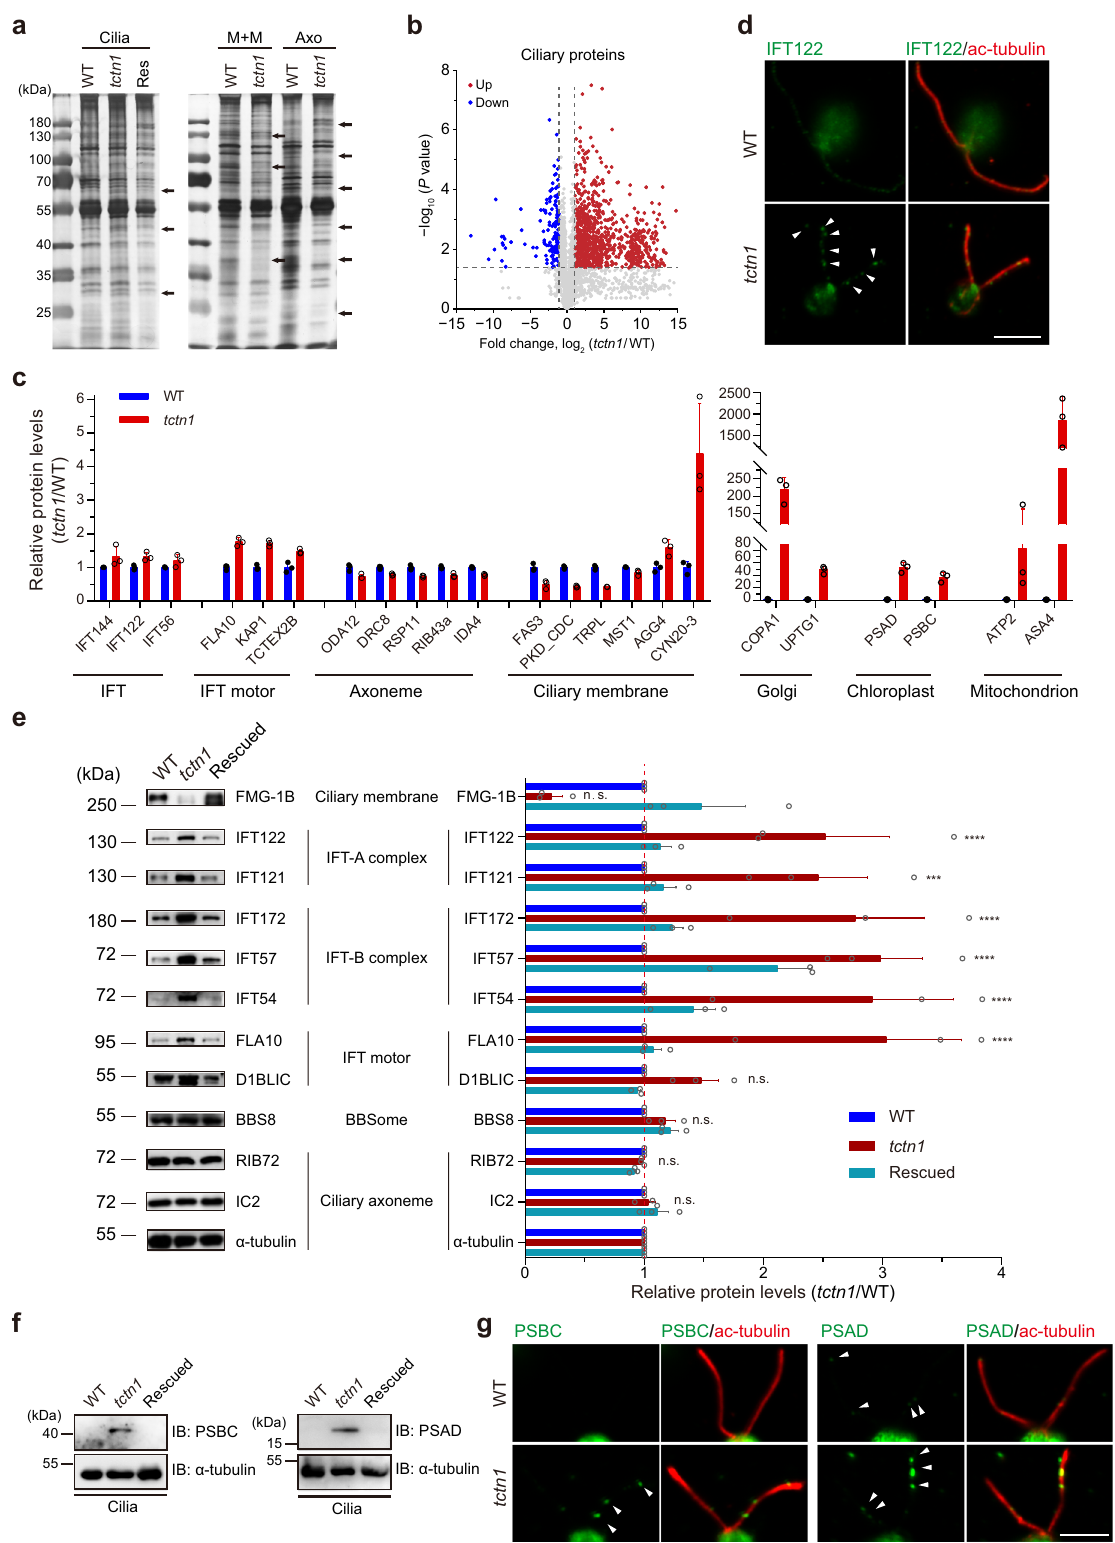
proteins, we performed proteomic analysis of WT and tctn1 cilia. of WT and tctn1 were isolated and subjected to silver gel staining Unexpectedly, a volcano plot showed that more proteins in cilia and proteomic analysis. Total ciliary protein (Cilia) and the were increased in tctn1 (Fig. 4b), which indicates that defects in membrane-matrix (M + M) and axonemal (Axo) fractions from the TZ not only impaired ciliary membrane protein concentration the WT, tctn1 and/or rescued cells were analyzed via SDS – PAGE. but also led to loss of the fi lter function to exclude other proteins Signi fi cant differences between the WT and tctn1 cilia were (Fig. 4c). Clearly, the histogram showed an increase in IFT identi fi ed (Fig. 4a). To pro fi le the systematic changes in ciliary NATURE COMMUNICATIONS| (2022) 13:3997